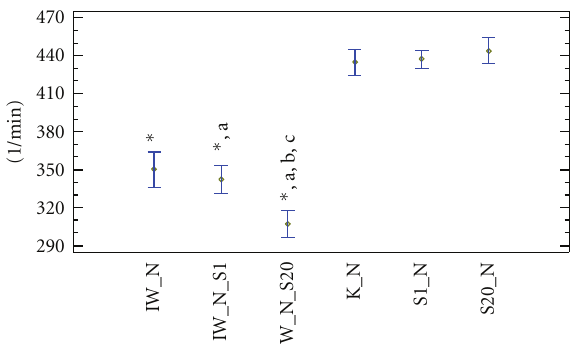
Figure 1: PAI–1 blood level (ng/mL) in Wistar rats fed normoc- holesterolaemic diet. K N: normocholesterolaemic control group,